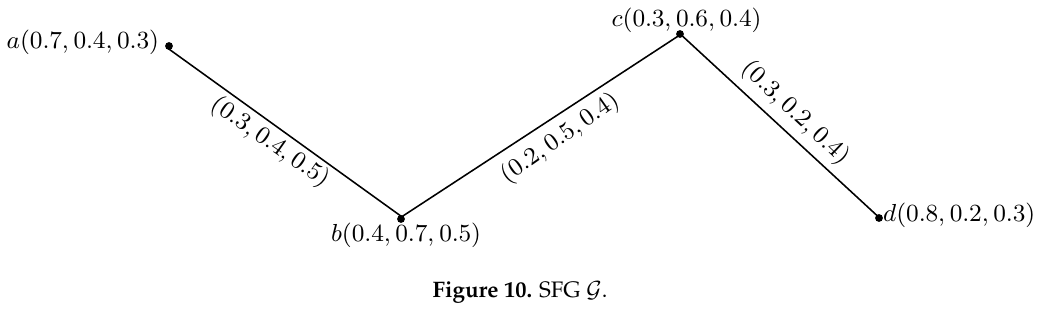
Figure 10. SFG G